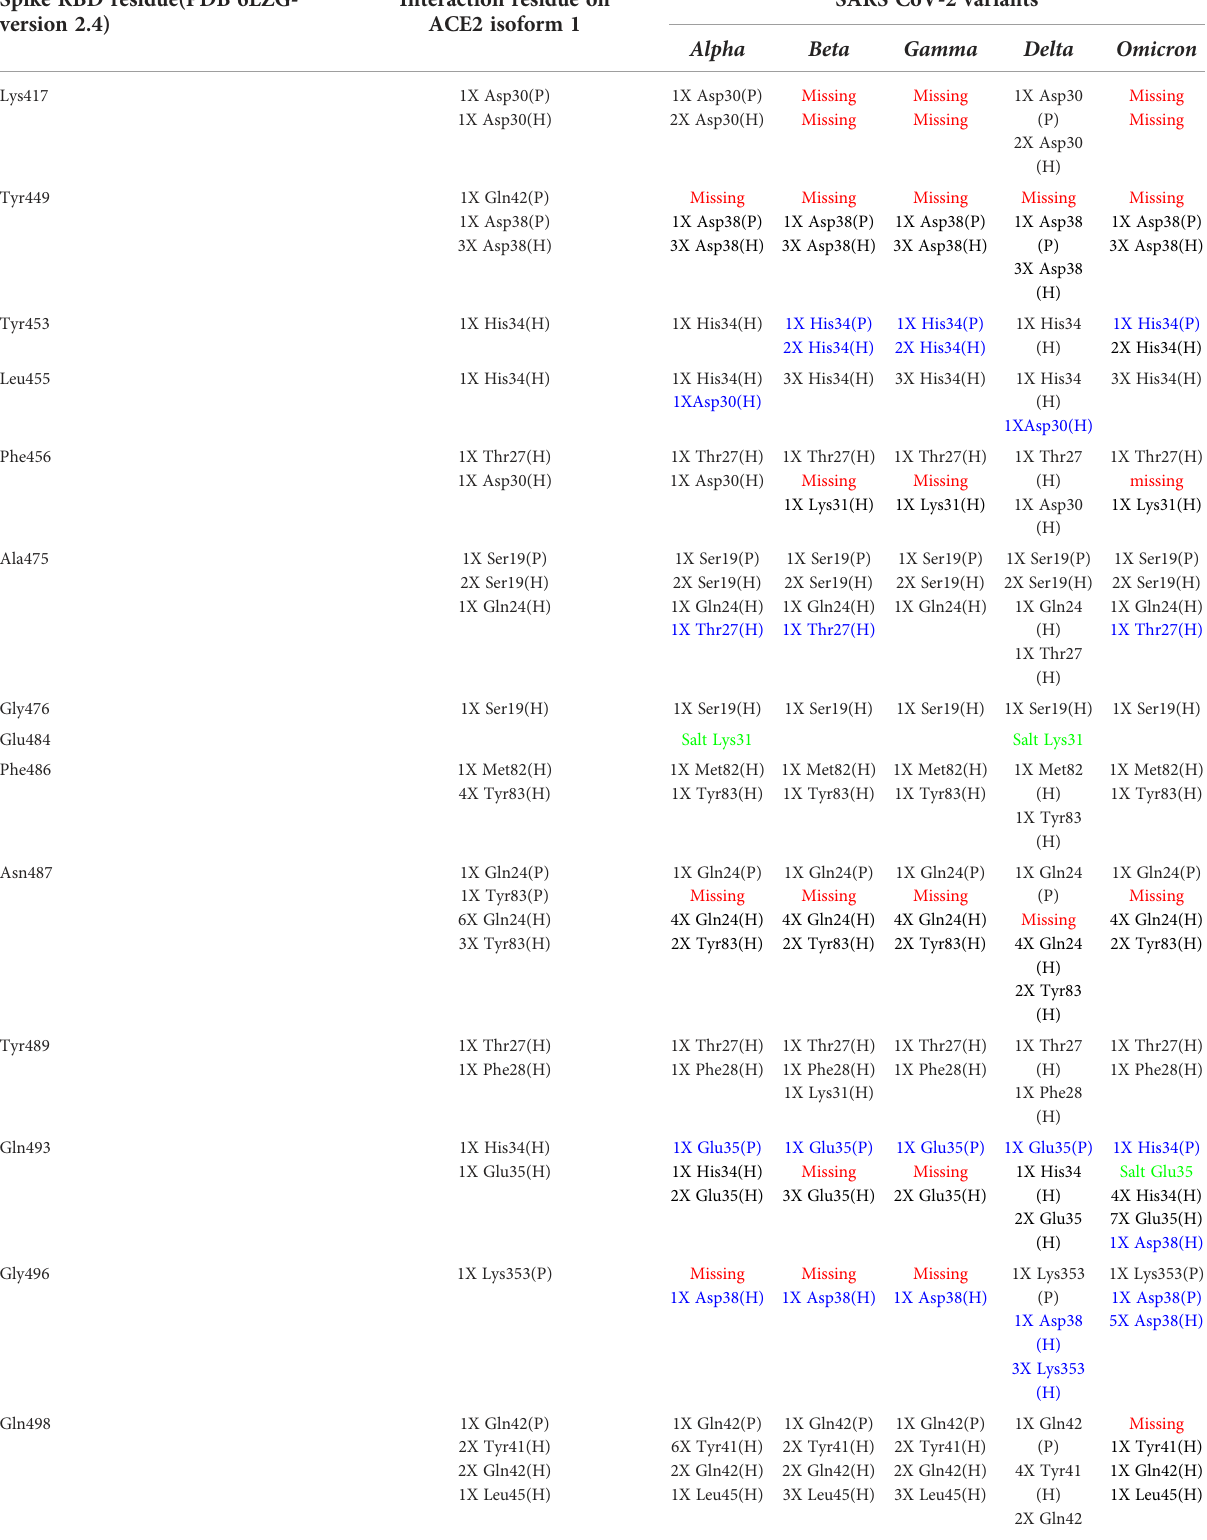
TABLE 5 S protein/ACE2 complex contact residues ’ interactions pattern of different SARS-CoV-2 variants. Spike RBD residue(PDB 6LZG- version